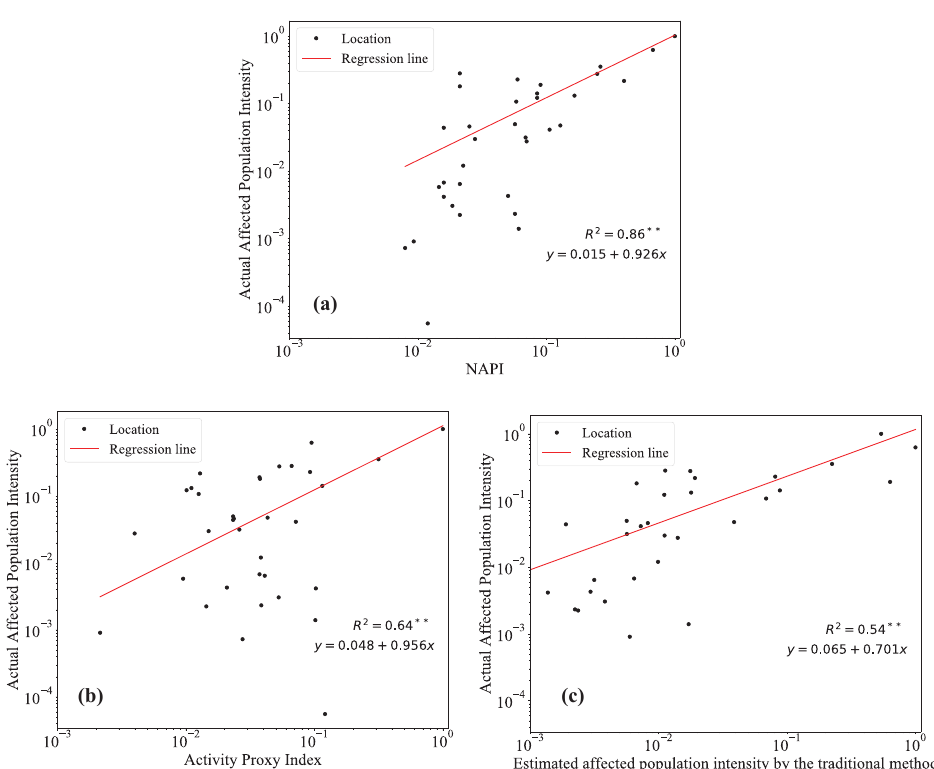
Figure 5. Regression analysis between each of the three methods and the actual affected population. ( a ) Relationship between NAPIs and the actual affected population intensity. ( b ) Relationship between the activity proxy index and the actual affected population intensity. ( c ) Relationship between the affected population intensity estimated by the traditional population-density-based method and the actual affected population